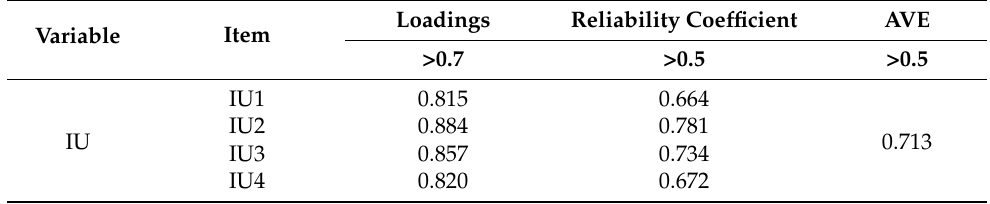
Table 3. Reflective variable accuracy. AVE: average explained